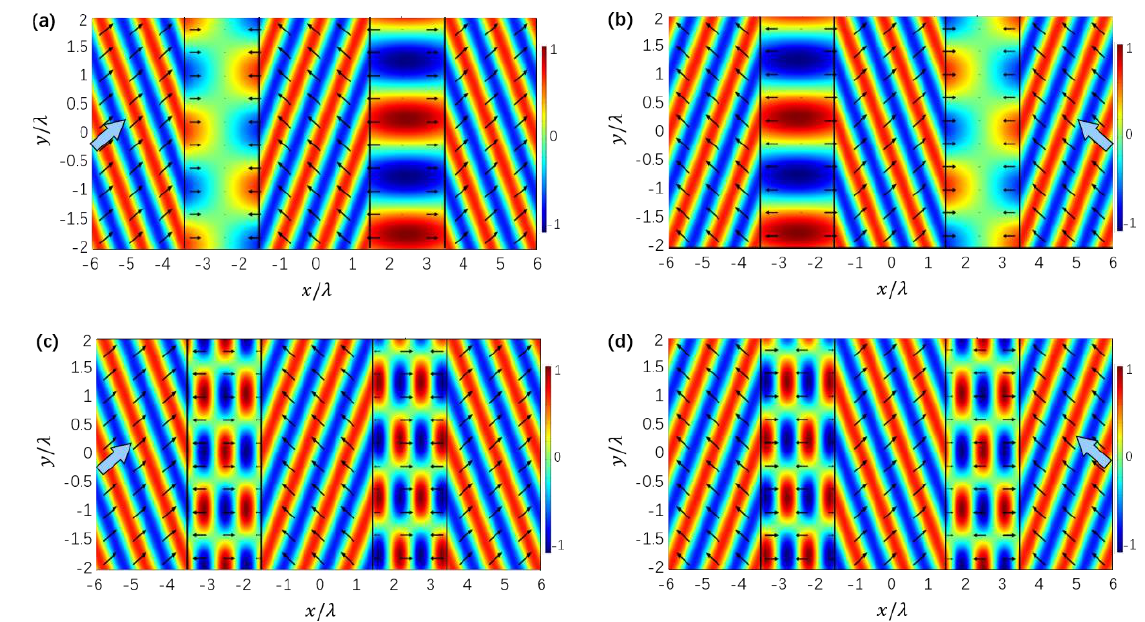
Figure 4. The simulated acoustic field patterns for negative using a pair of identical PIMs supporting the coexistence of CPA and laser modes. ( a , b ) are the simulated acoustic field patterns when the waves are incident from the left and right sides, respectively. The relative coefficients are ρ r = 0.14 and β r = 1.84. ( c , d ) are the simulated acoustic field pattern for the incident waves from the left and right sides, respectively. The relative coefficients are ρ r = 1.01 and β r =